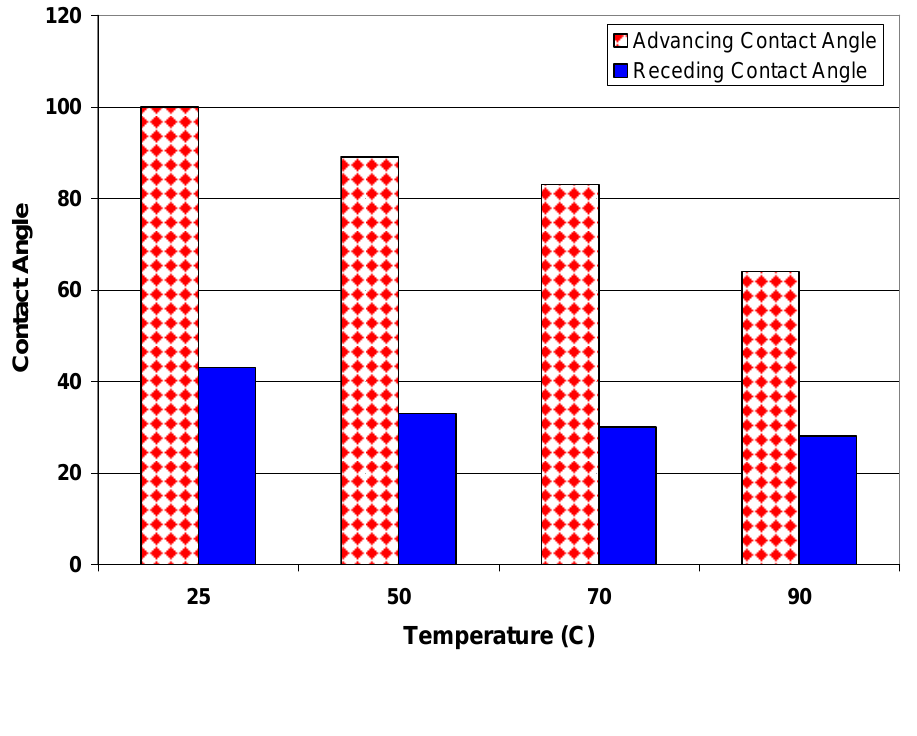
Figure 7. Advancing and receding contact angles as a function of temperature in a water medium for modified calcite surfaces with 0.005M SA dissolved in n